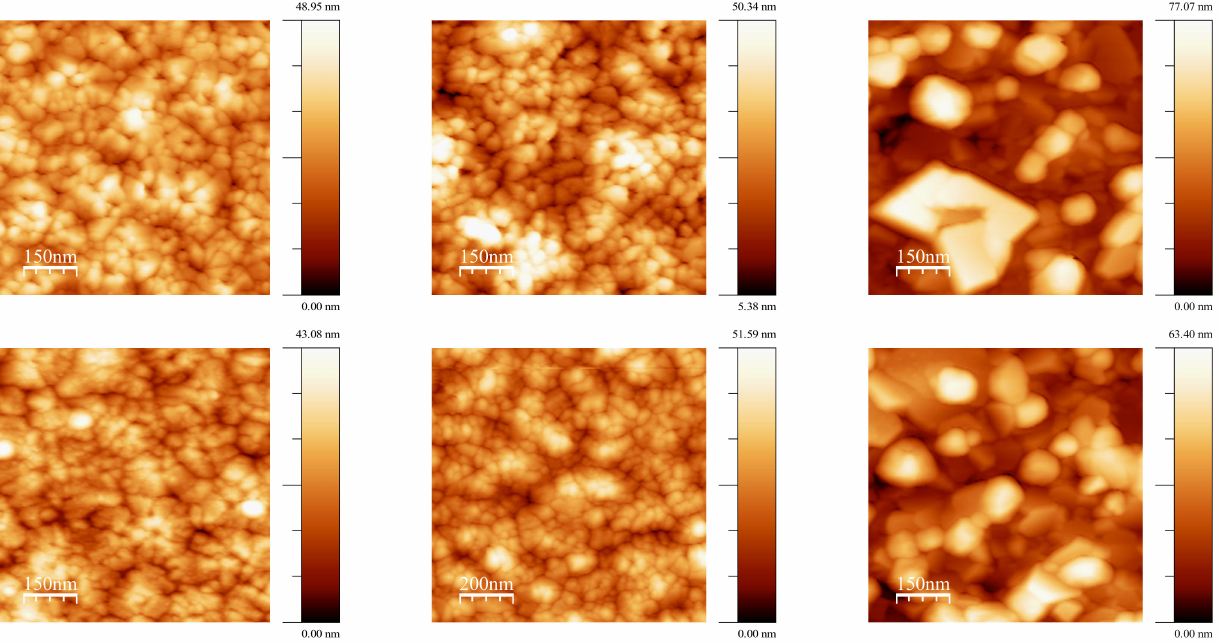
Figure 2. Surface structure of BiFeO 3 ( top row ) and Bi 0 . 9 La 0.1 FeO 3 ( bottom row ) sol–gel films obtained by AFM at 550 ◦ C ( left column ), 600 ◦ C ( middle column ) and 700 ◦ C ( right column